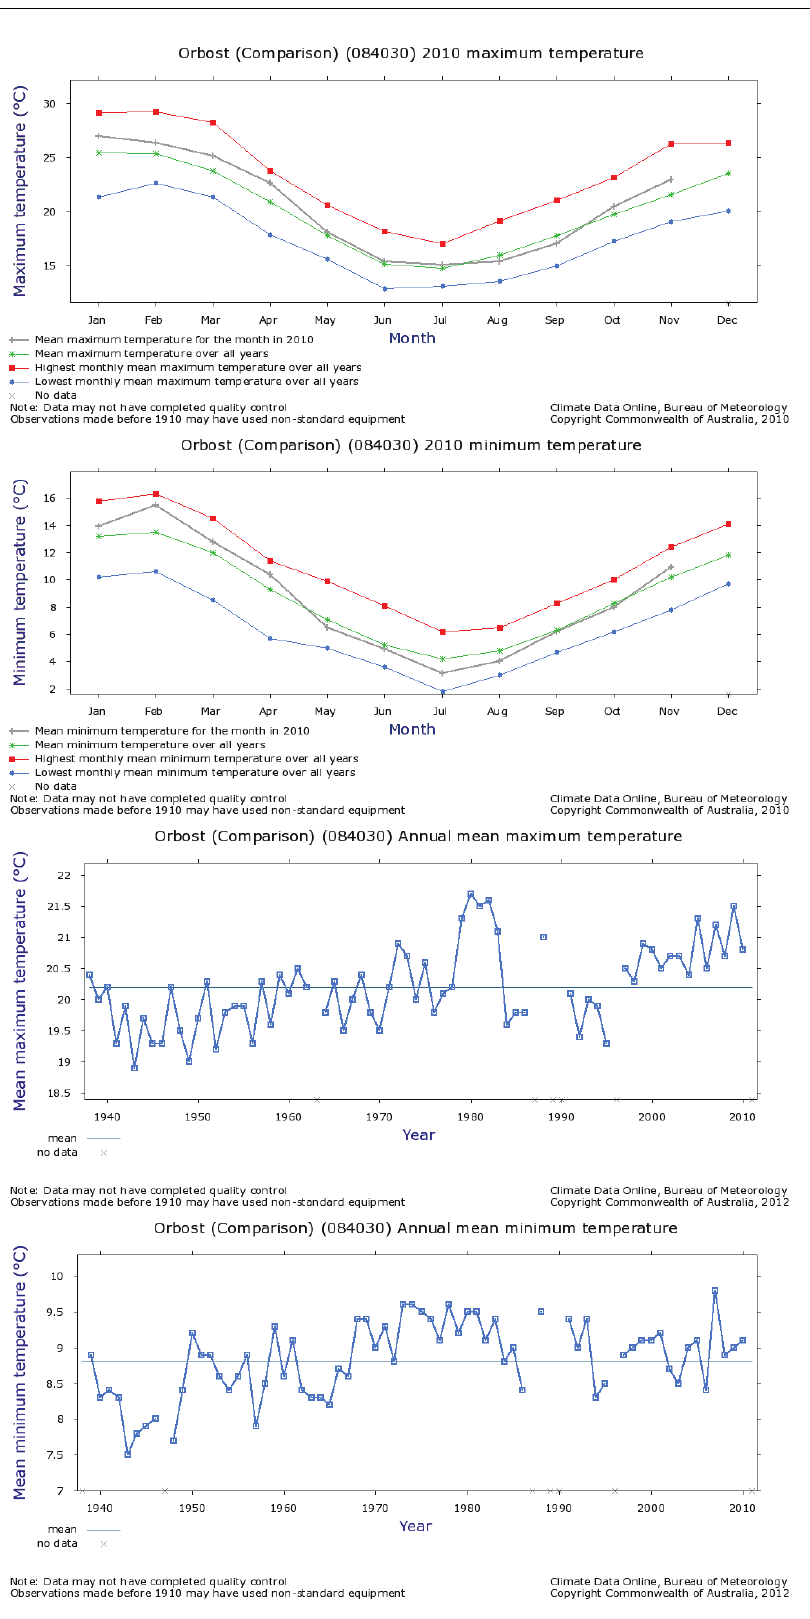
Figure 10. Australian Government Bureau of Meteorology temperature graphs for historical locations in Victoria, Aus-